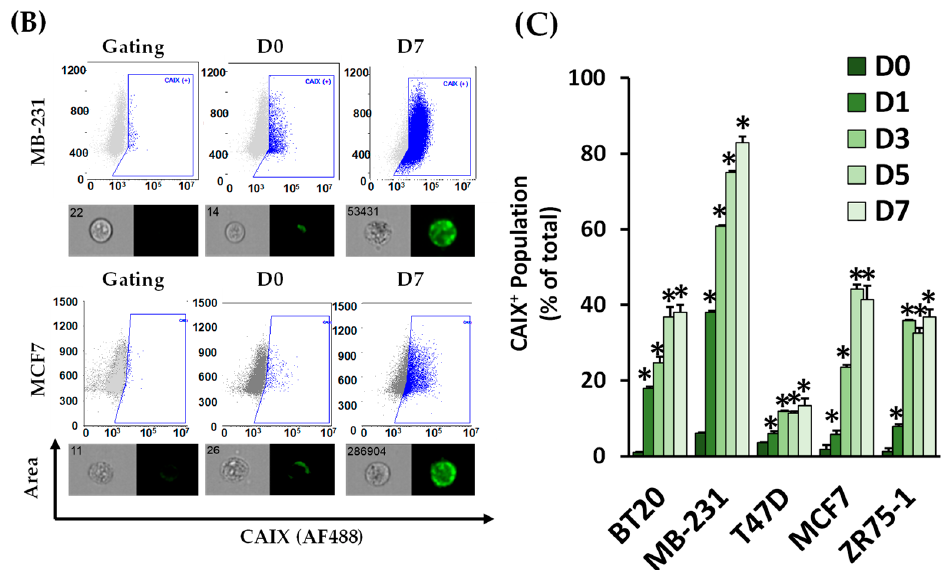
Figure 3. Suspension-cultured breast cancer cell lines expressed high levels of carbonic anhydrase IX. ( A ) Breast cancer cell lines were collected from the monolayer (D0) following 7 days of suspension culture (D7) and analyzed using immunoblotting for markers identified in the top dysregulated cell surface proteins as well as HIF1 α . Carbonic Anhydrase IX (CAIX) and ENO2 were significantly upregulated following suspension culture in the cell lines studied. ( B ) The surface expression of CAIX was detected using MIFC with gating performed on the isotype and unlabeled controls for each cell line. ( C ) CAIX surface expression increased in each cell line over the 7 days of culture, with the most prominent expression seen in MB-231, MCF7, and ZR75-1 cells. CAIX + populations were quantified at each indicated time point. (n = 3, * p < 0.05, relative to monolayer culture).